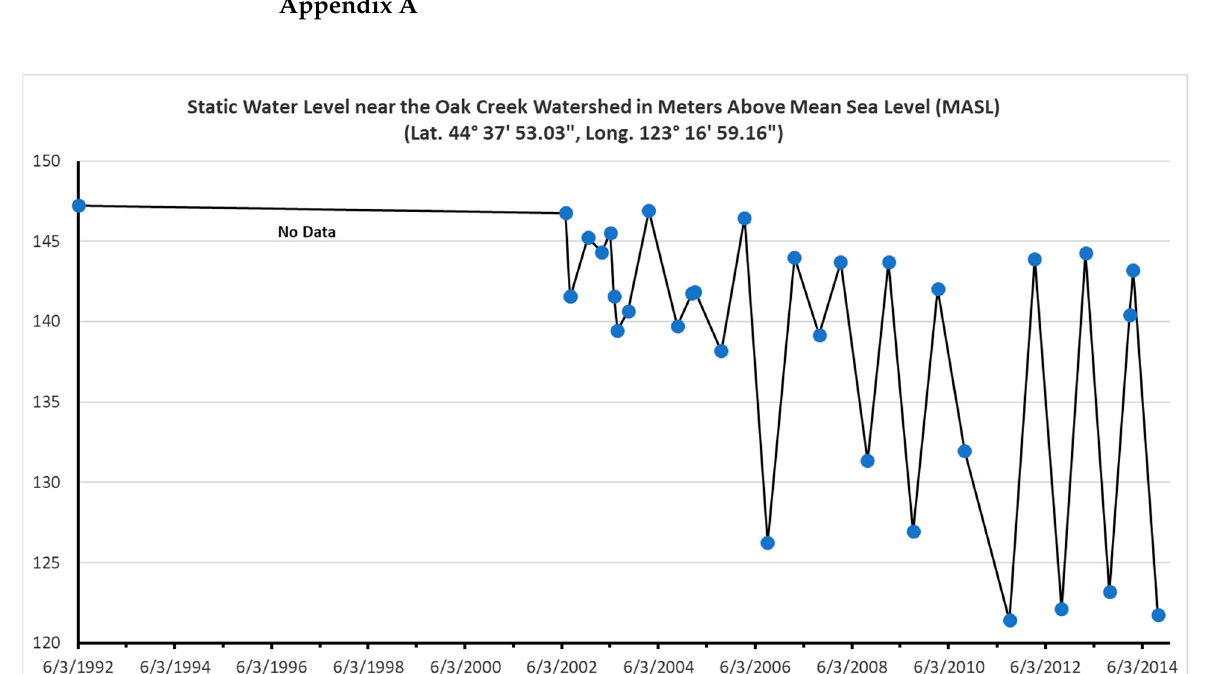
Figure A1. Example of Static Water Level Measurements at Observation Well near the Oak Creek Watershed (OCW), Corvallis, Orgon, USA. Data source (https://www.oregon.gov/owrd (accessed on 30 January 2022)).